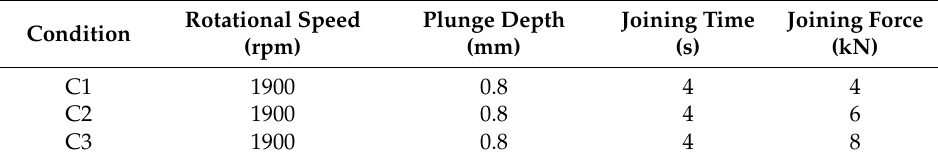
Table 4. Joining parameters used in the current study.